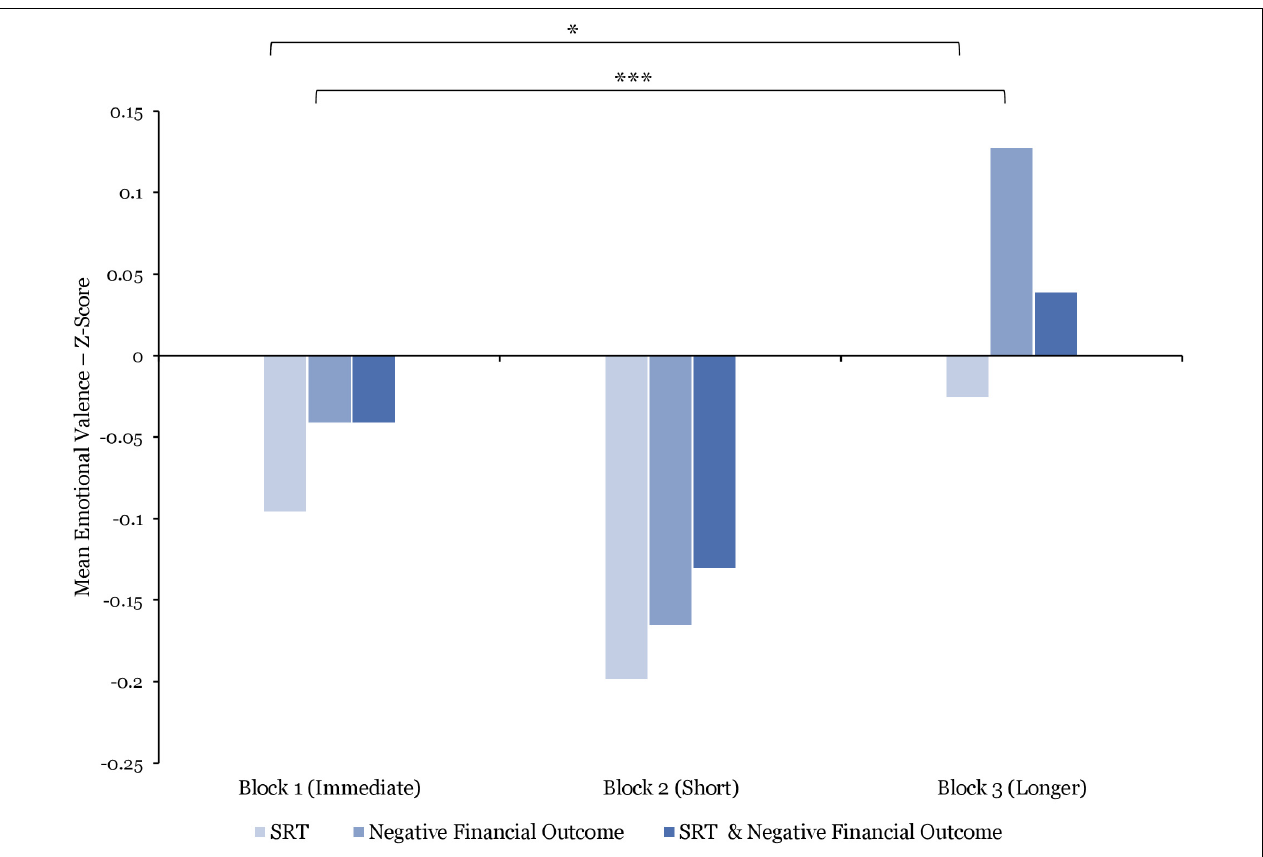
FIGURE 9 | Comparisons of mean emotional valence (z-score) by stress manipulations and by blocks. Significant differences are marked as ∗ p < 0.05; ∗∗∗ p <